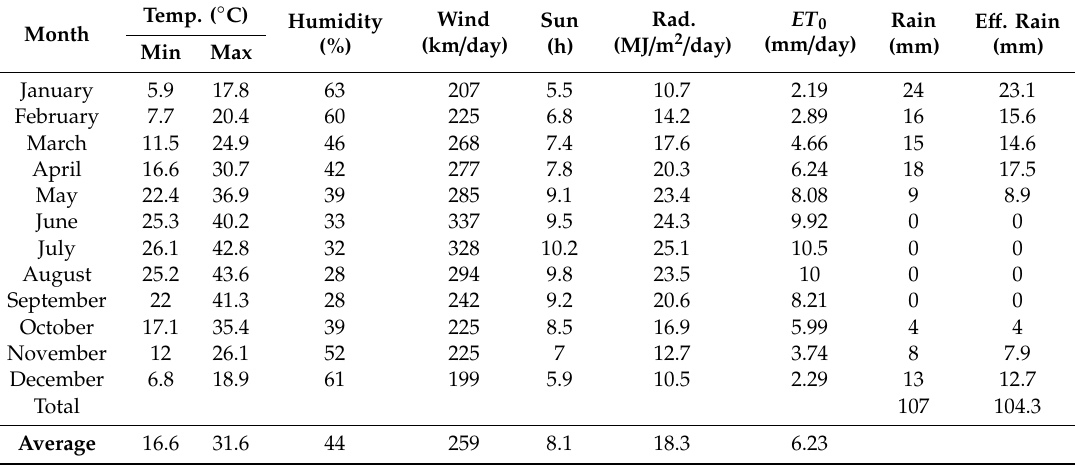
Table 2. Climate characteristics, rainfalls, and ET 0 of Nasiriya area (average for 1970–2000 period) obtained using the CLIMWAT tool attached to the CROPWAT